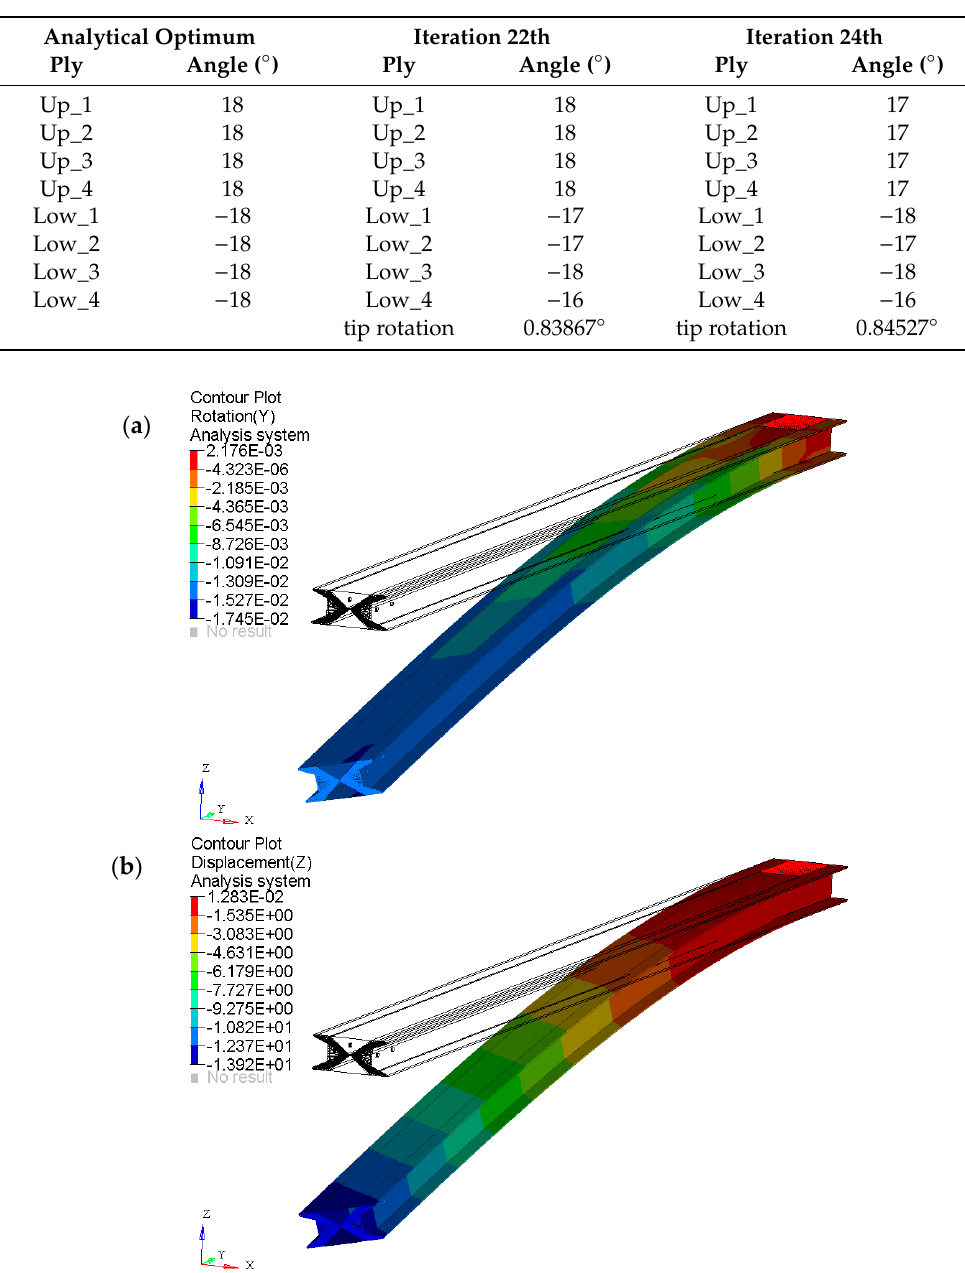
Figure 11. FE analysis results of box beam numerical optimum lay-up: ( a ) Y-rotation result; ( b ) Z-deflection result.